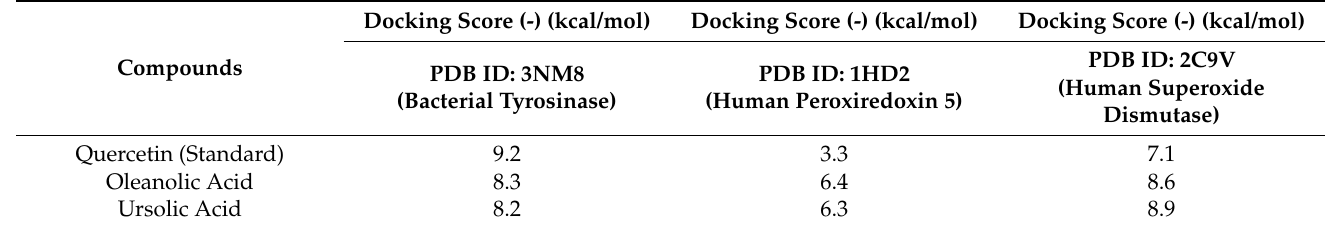
Table 5. Docking analysis of two triterpenes ligands on three different protein receptors with respect to Quercetin standard.